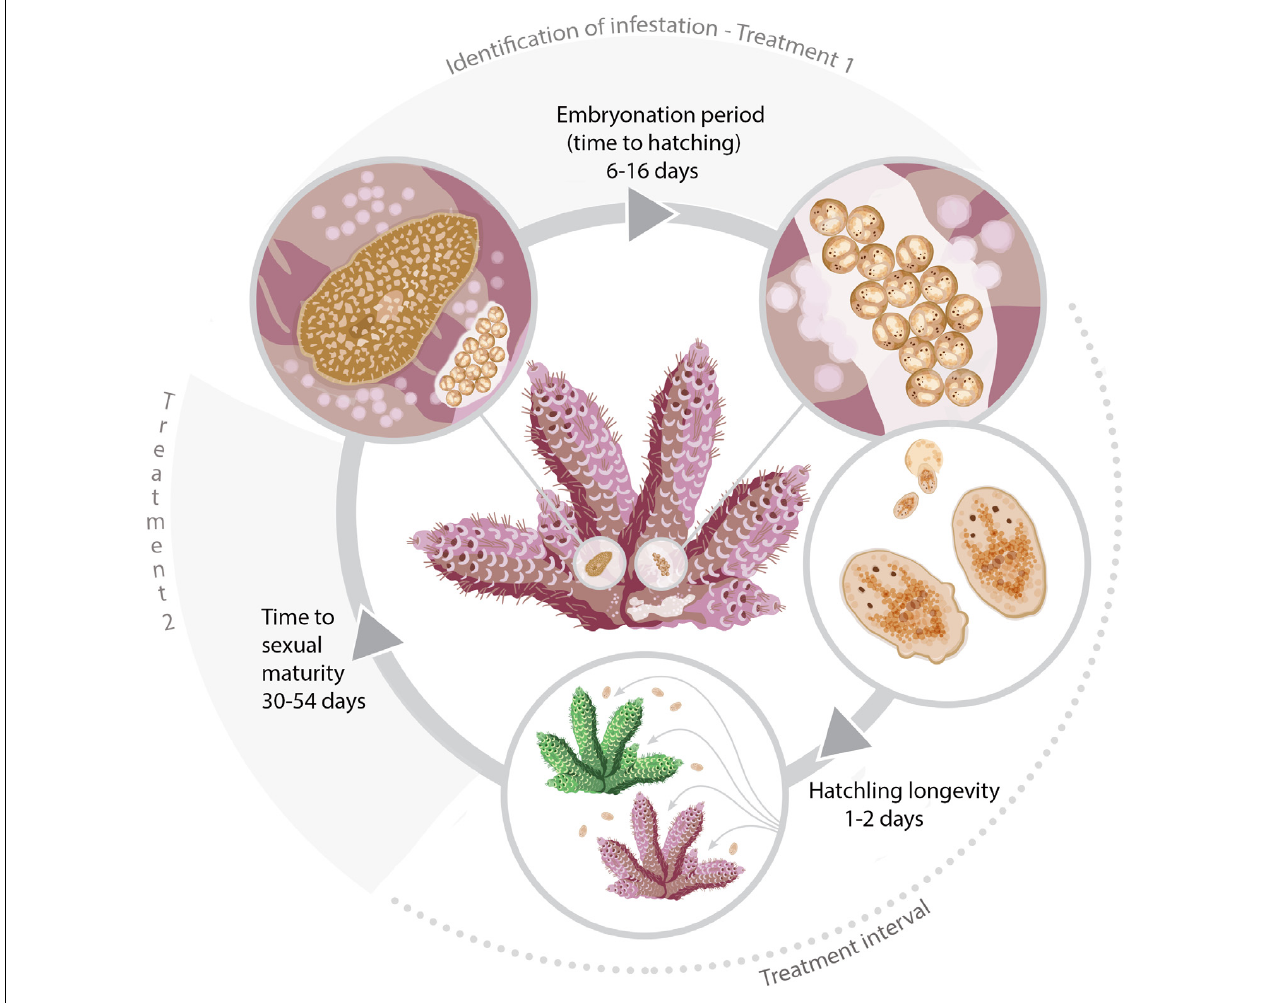
FIGURE 5 | The life cycle of P. acroporae measured at 3 ◦ C increments from 24 to 30 ◦ C and the recommended timings of treatments (see section “Discussion”).